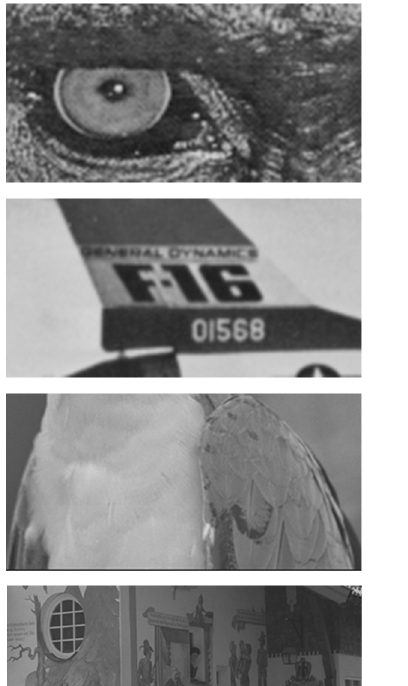
Figure 17. Two original images of USC-SIP dataset: ( a ) parrots and ( e ) house. Enhanced images obtained by algorithms in ( b , f ) [21], ( c , g ) [31], and ( d , h ) the present proposal.